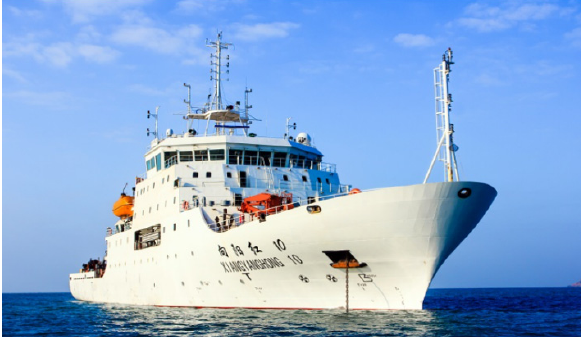
Figure 22. A picture of the ship Xiangyanghong No. 10.